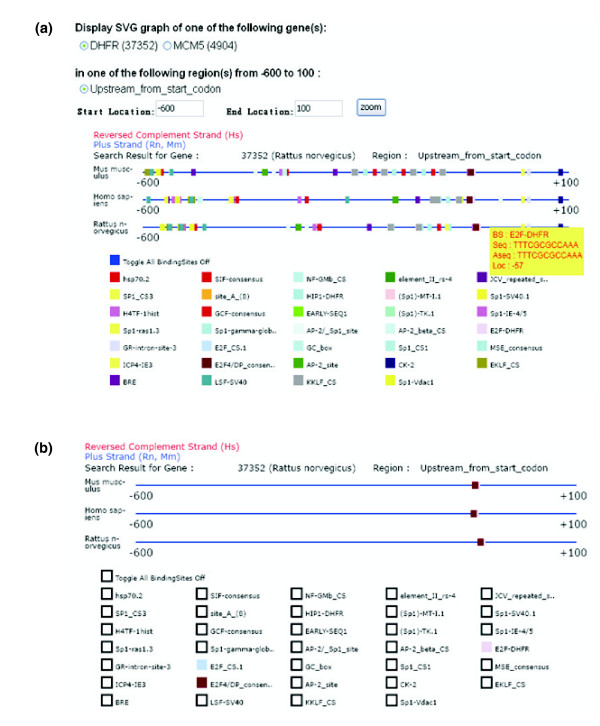
Graphic display of transcription binding sites in the DHFR promoter region. (a) Visualization of DHFR upstream region. Same parameters were used as for MCM5 (see Figure 6). (b) Same region as shown in panel a, with only the E2F sites highlighted. E2F, elongation factor-2.